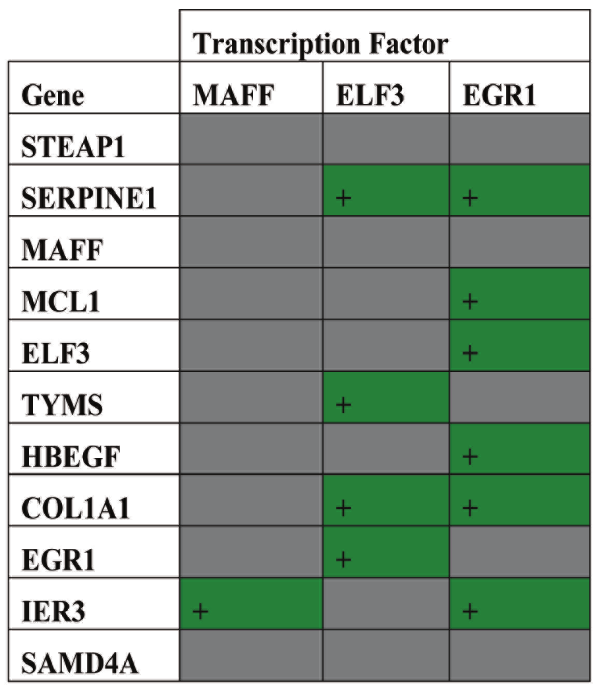
Figure 3. Transcription factor analysis. Green shade indicates the presence of a transcription factor binding site sequence, upstream from the gene of interest. Each row represents a gene of interest, and each column represents a putative transcription factor.